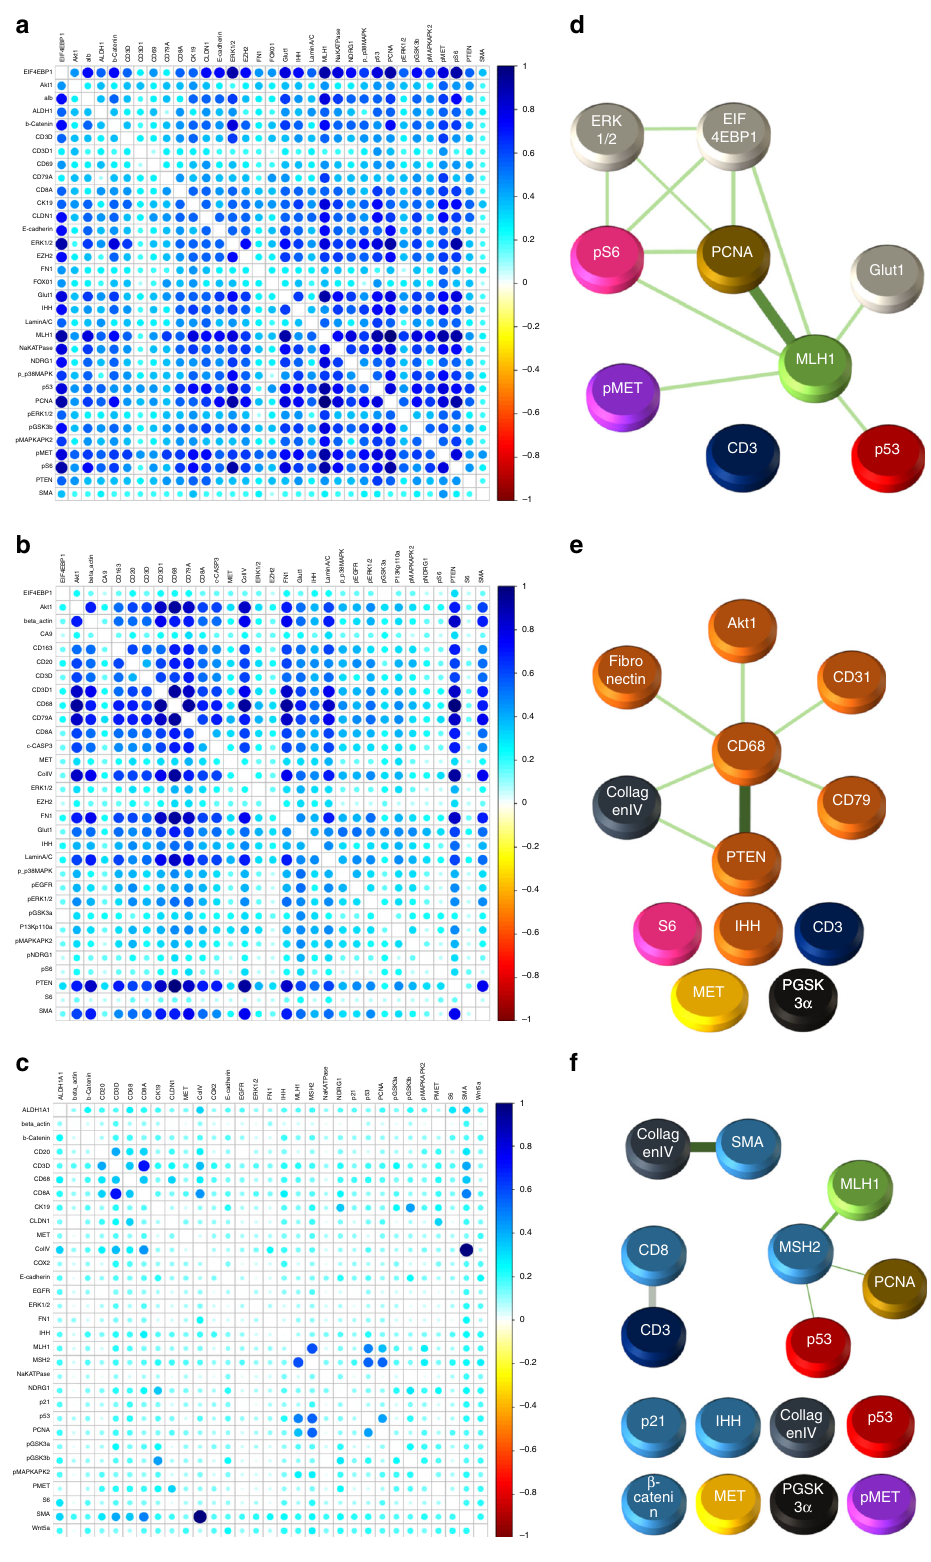
evident. The association of these two subnetworks in the epithelial domain has the potential to promote tumor cell growth while escaping immune surveillance. Finally, we observe a prominent tumor associated macrophage (TAM) network in the stromal spatial domain (Fig. 5e). TAM polarization toward the M2 phenotype regulated by AKT/PTEN has been